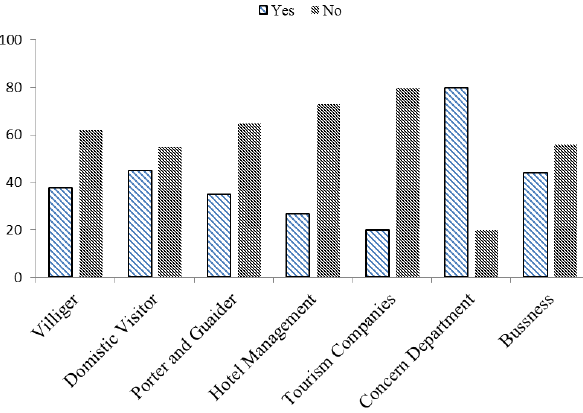
Fig. 2. The understanding of all stakeholders about